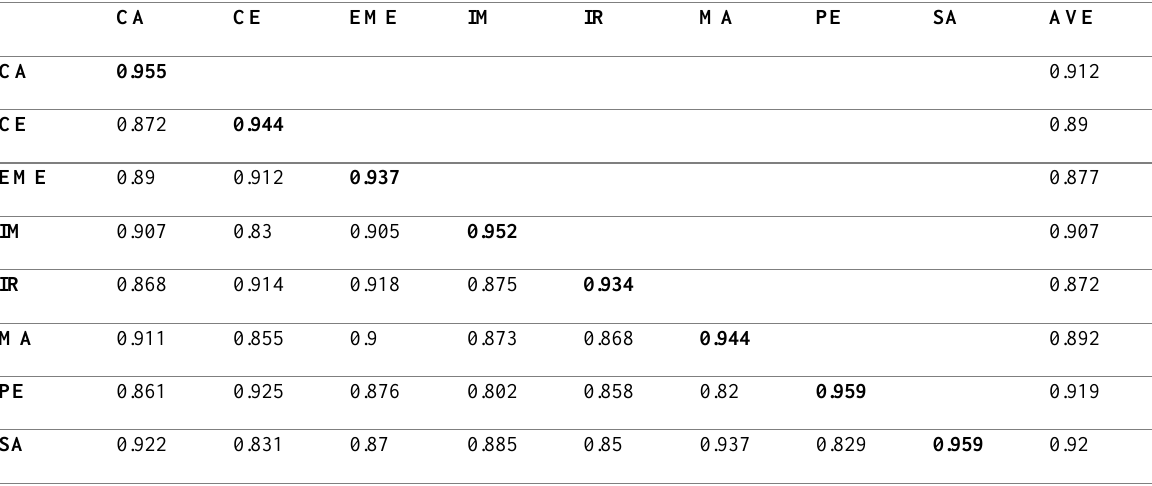
Table 5: Discriminant validity of the